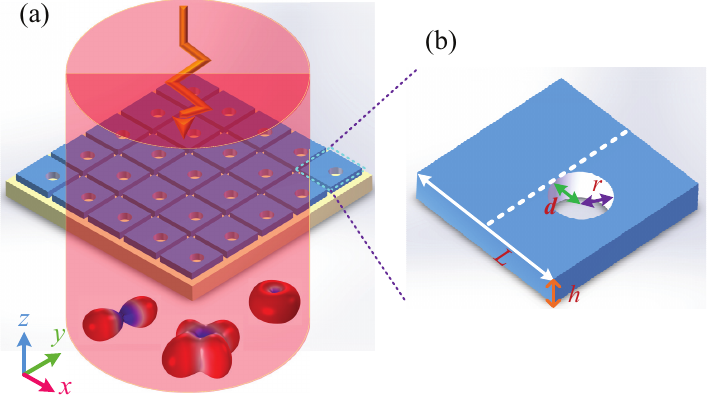
Figure 1. ( a ) Schematic of light radiation manipulated by the resonant metasurface. ( b ) Geometry of unit cell, L is the length of the side of a Si square block, h is the thickness, r is the radius of air-hole, d is the distance between the air-hole and the center of the square, which is the asymmetric